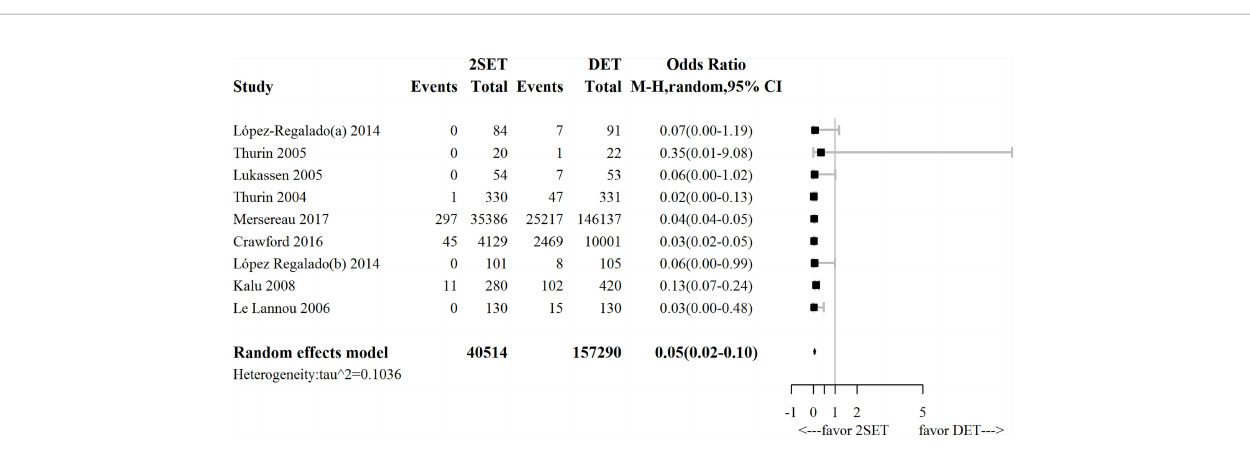
Table 3 summarizes the overall results of the maternal pregnancy and neonatal outcomes analyses.